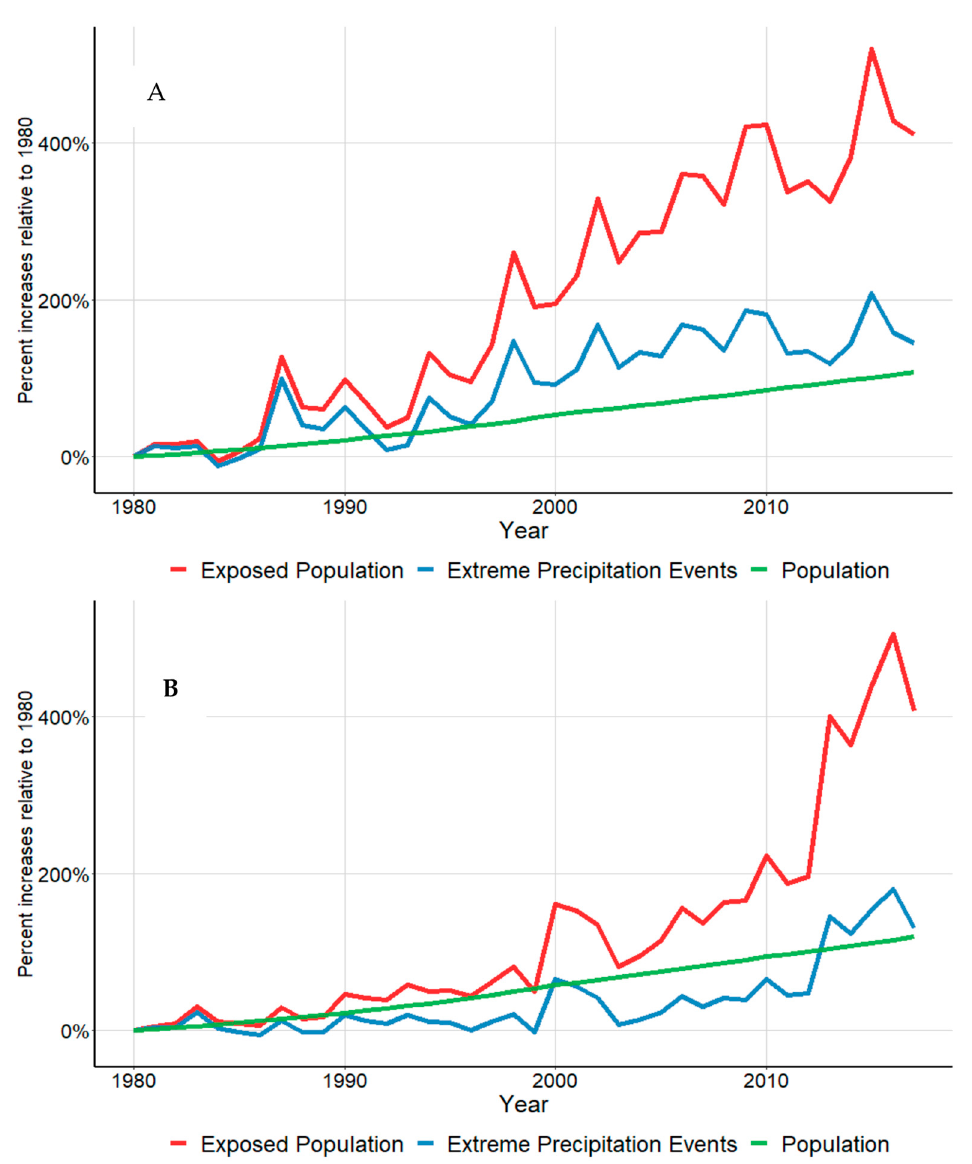
Figure 2. Changes in EHE ( A ) and EPE ( B ) exposed populations during the last four